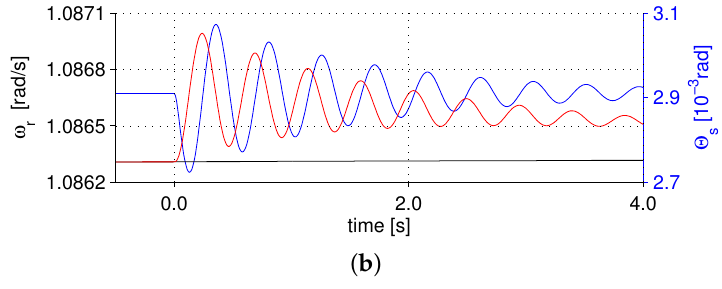
Figure 9. Generator failure in the partial load region at constant wind speed 8 m/s. ( a ) otal generator torque T g (red line), demanded torque T g , d (black line), and n generators (blue line); ( b ) rotor speed ω r (red), demanded rotor speed ω r (black), shaft torsion angle Θ s (blue).